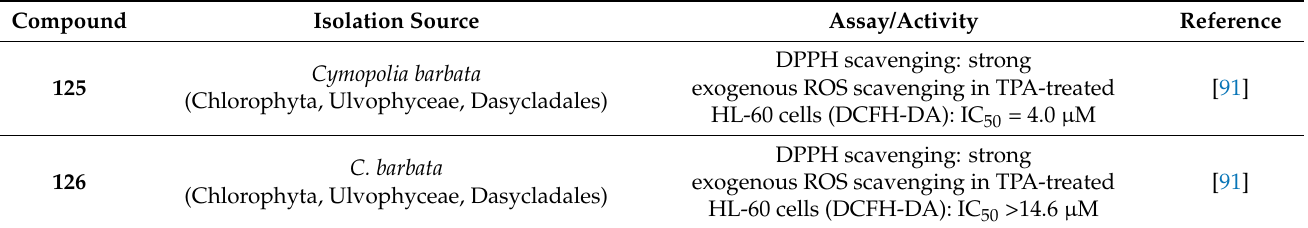
Table 4. Meroterpenoids from macroalgae with antioxidant activity.